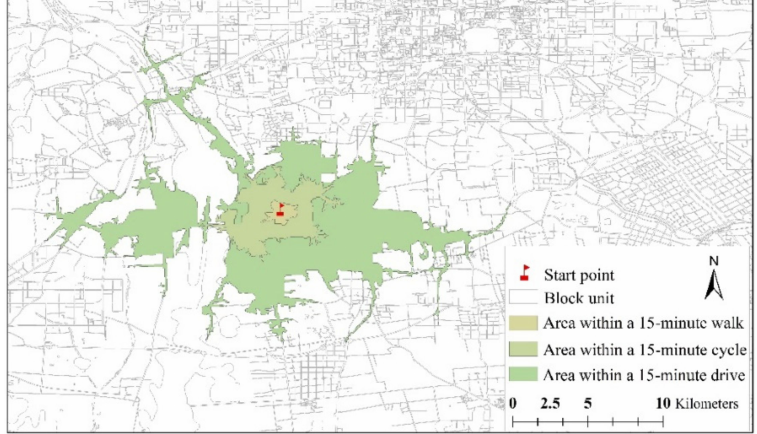
Figure 5. Example of isochrone data obtained using the isochrone